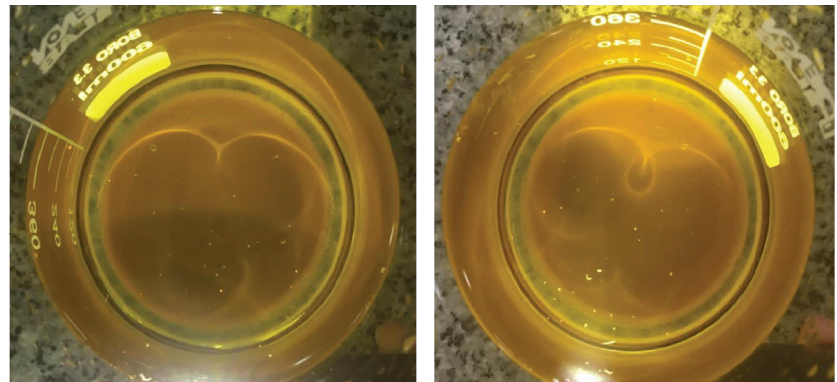
Figure 2: Sedimentation of precipitates and suspension of microplastic and microfber particles on the surface after acid